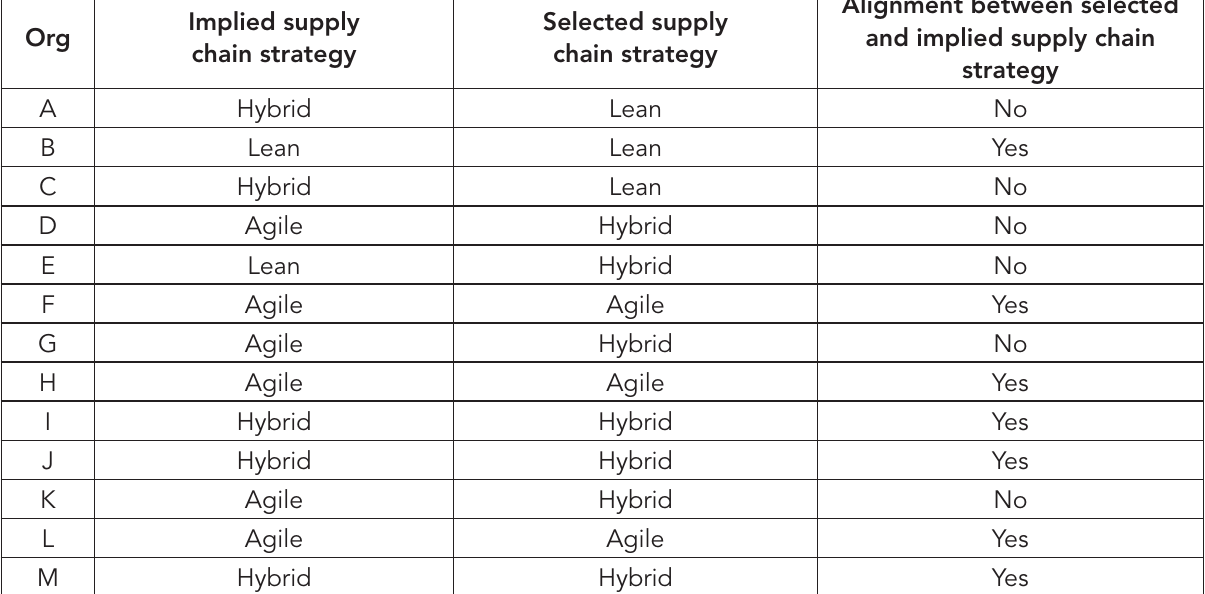
Table 4: Implied (and selected) supply chain strategies based on market